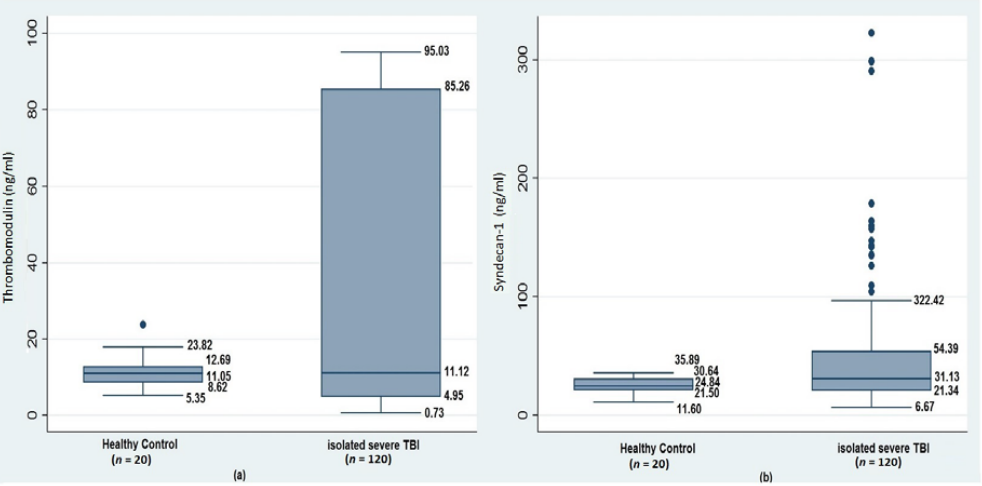
Figure 2. Comparison of plasma levels of (a) thrombomodulin ng/mL and (b) syndecan-1 ng/mL between healthy controls (HCs) and patients with isolated severe TBI (sTBI). Table 2. Correlation of glycocalyx shedding and endothelial disruption with acute TBI-associated coagulopathy.